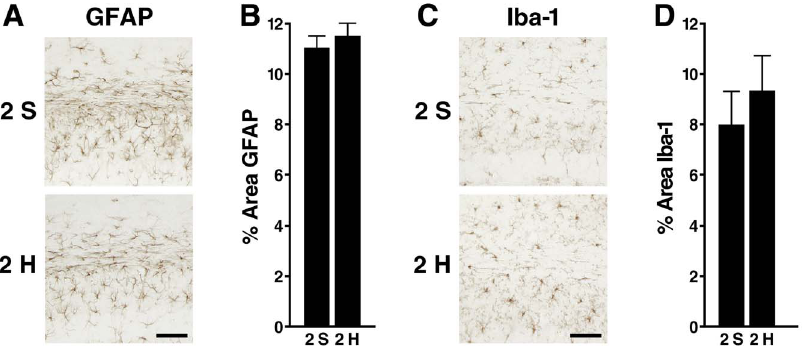
Fig. 9. Wildtype mice have no callosal astrocytosis or microgliosis 12 months after 2-hit frontal injury. Wildtype mice (n 5 8–10 per group) received a 2-hit frontal impact injury or sham treatment, underwent behavioral testing 2–6 weeks later, and were analyzed histologically 12 months after the initial injury. Coronal brain sections were immunostained for GFAP or Iba-1(A, B) Representative images (A) and quantitation (B) of GFAP immunoreactivity in the corpus callosum. (C, D) Representative images (C) and quantitation (D) of Iba- 1 immunoreactivity in the corpus callosum. Sh, Sham, H, Hit. Scale bar: 80 m m. Data are means ¡